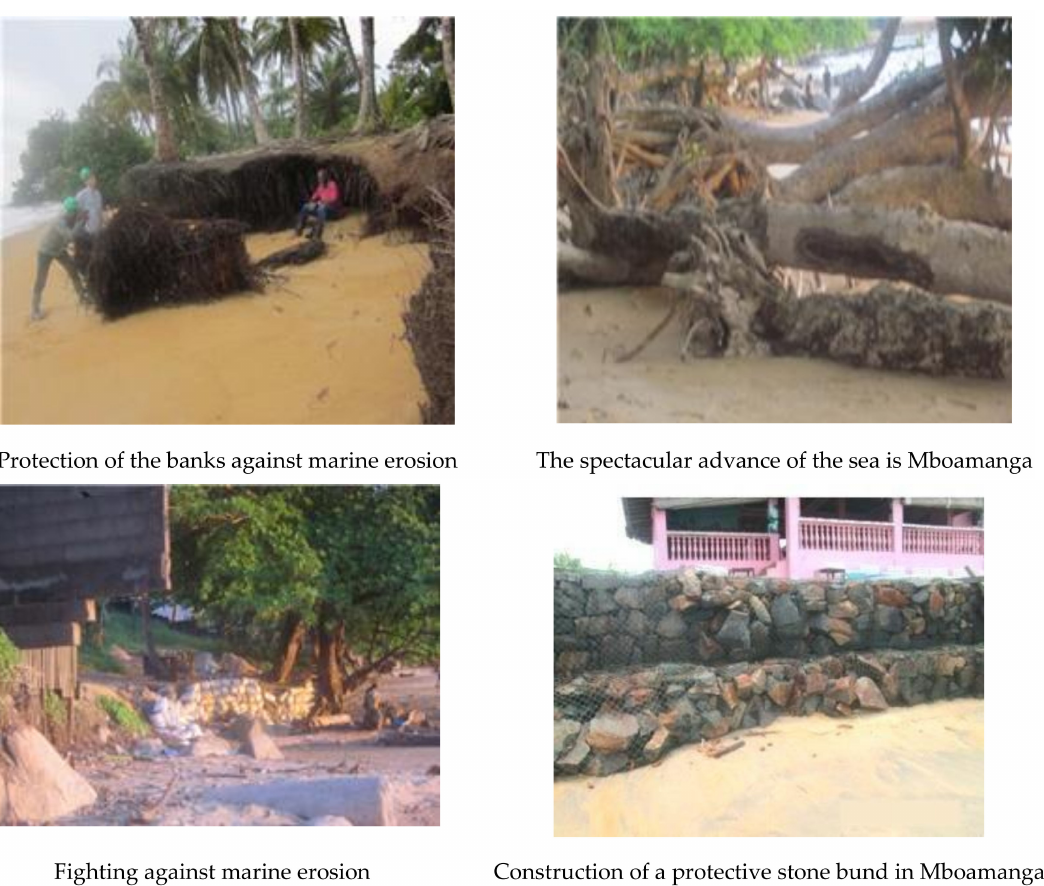
Figure 20. Coastal Erosion at work on the Kribi coastline and ineffective local response measures (Source: CUK